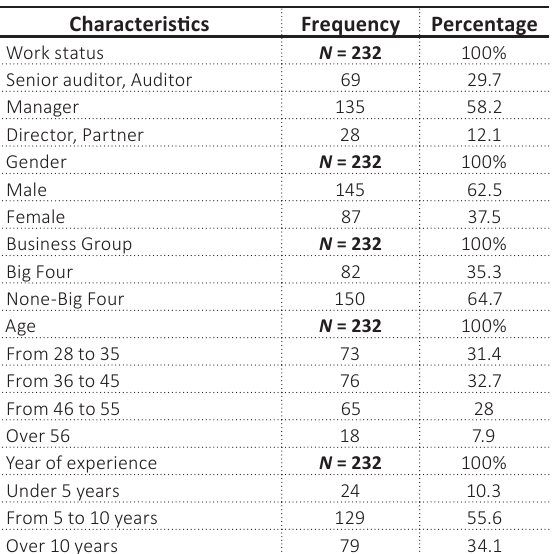
Table 1. Descriptive statistics of the survey